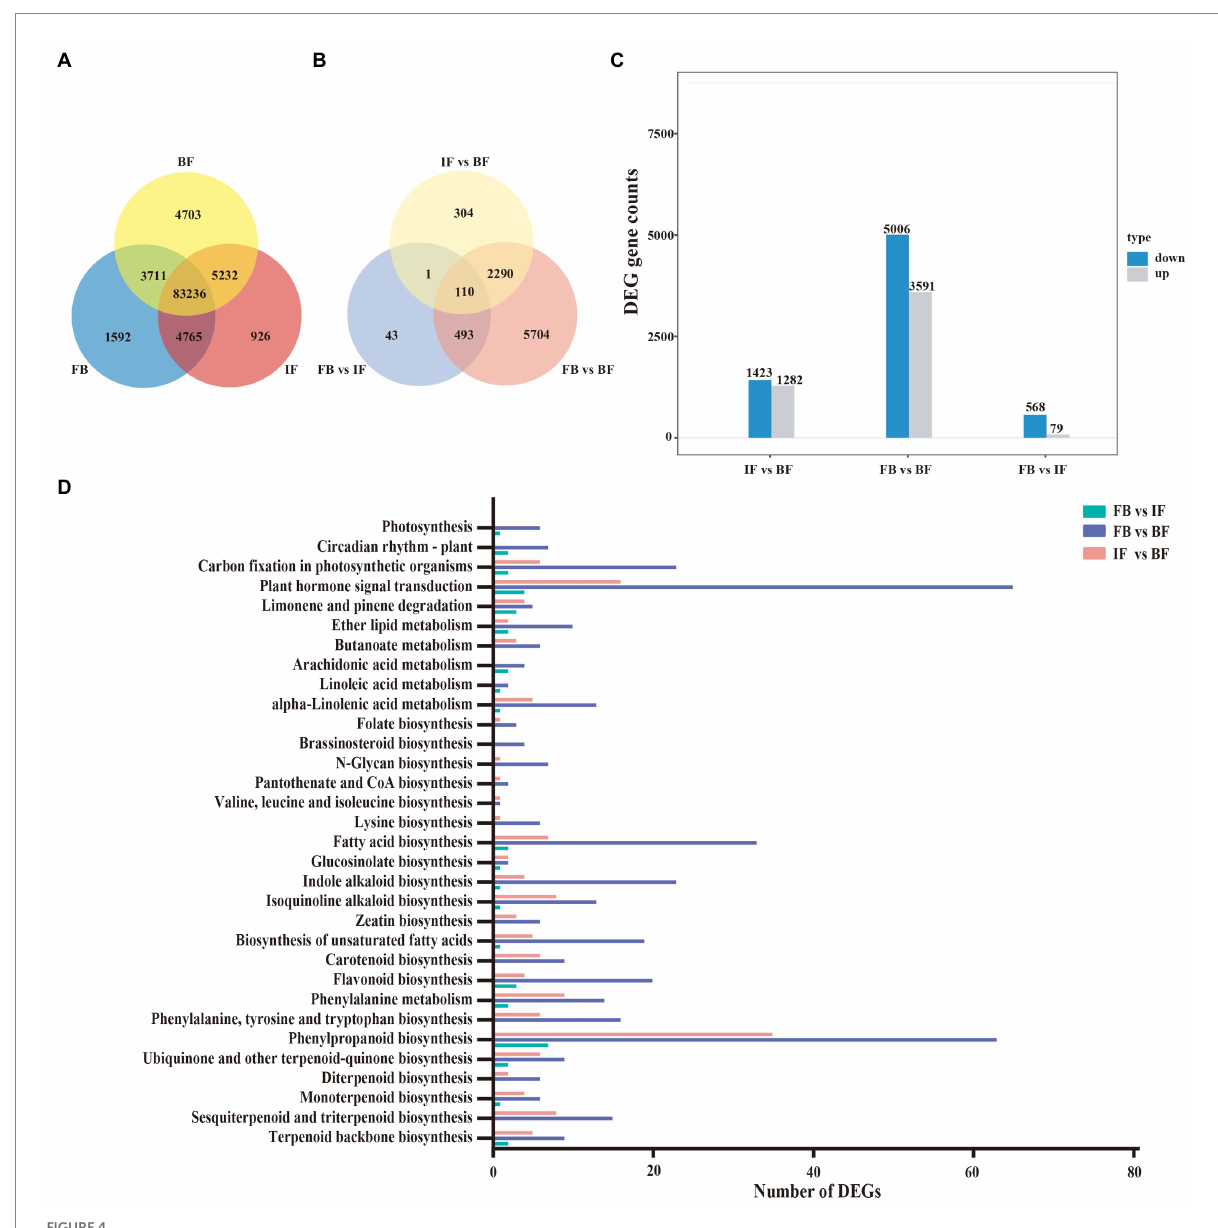
FIGURE 4 Gene expression and functional classification of DEGs in Chrysanthemum indicum var. aromaticum flowers. (A) Venn diagram of genes expressed at three different flower developmental stages. (B) Venn diagram of differentially expressed genes from three comparisons between different floral development stages. (C) Histogram of up- and downregulated genes with the latter as the reference in three comparisons. (D) KEGG enrichment analysis of DEGs from three